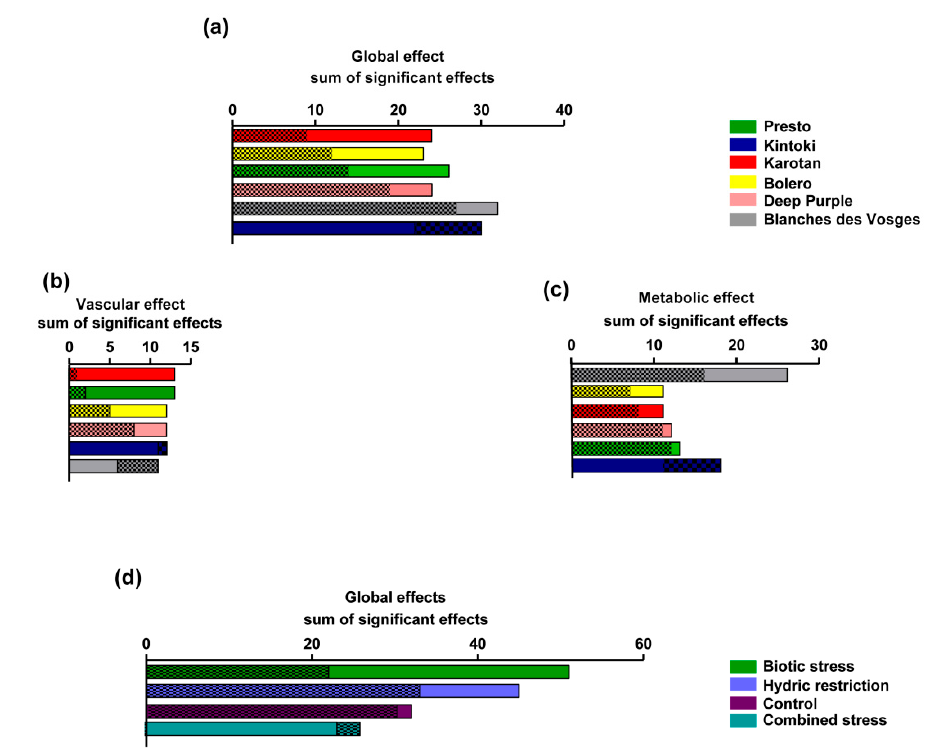
Figure 6. Ranking of the pharmacological e ff ects generated from the cellular responses. Sum of the pharmacological responses that were significantly beneficial (not dotted histograms) or deleterious (dotted histograms) on all examined cells ( a ), with respect to varieties on endothelial and smooth muscle cells ( b ) and hepatocytes and adipocytes ( c ). Sum of the significantly di ff erent pharmacological responses that were beneficial and deleterious observed in all types of cells considering di ff erent storage growing conditions ( d ). Beneficial e ff ects are represented by no-dotted histograms while deleterious e ff ects by dotted